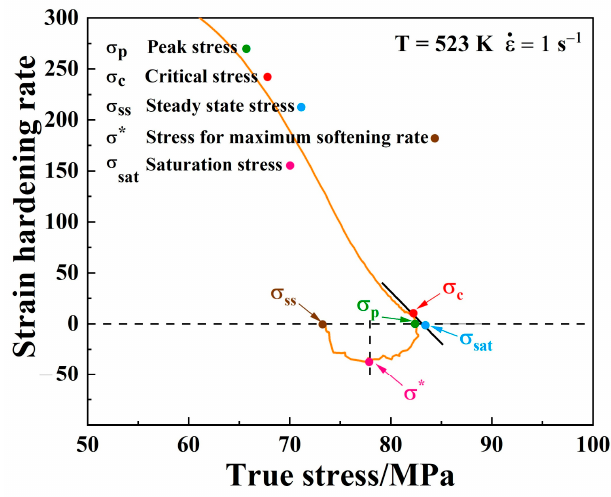
Figure 9. Schematic diagram of the relationship between Θ and σ at 523 K and 1 s − 1 in Mg-3Bi alloy.